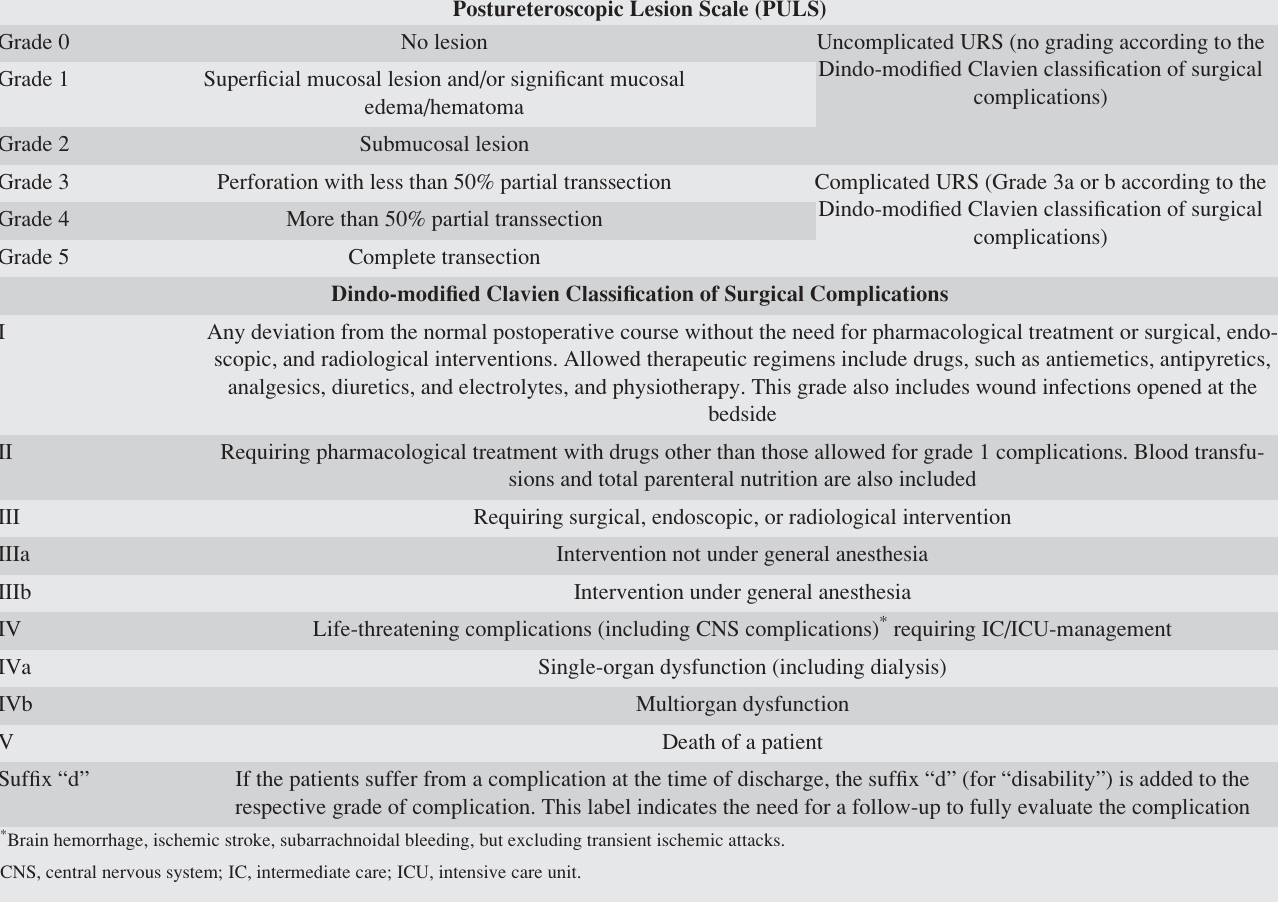
Table 1. Postureteroscopic Lesion Scale (PULS) and Clavien-Dindo Classification 6,7 Postureteroscopic Lesion Scale